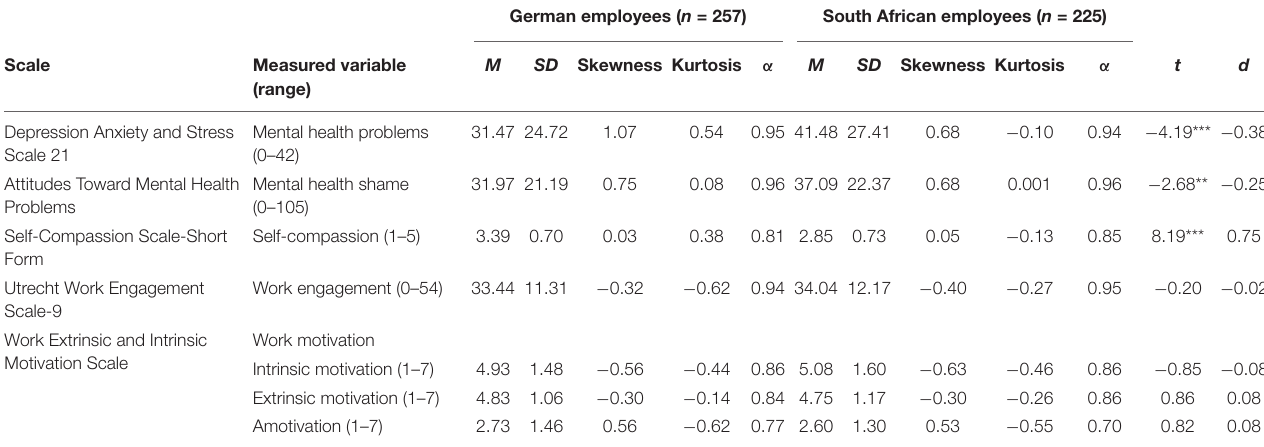
TABLE 1 | Descriptive statistics and t -tests: Mental health problems, mental health shame, self-compassion, work engagement and work motivation in German employees and South African